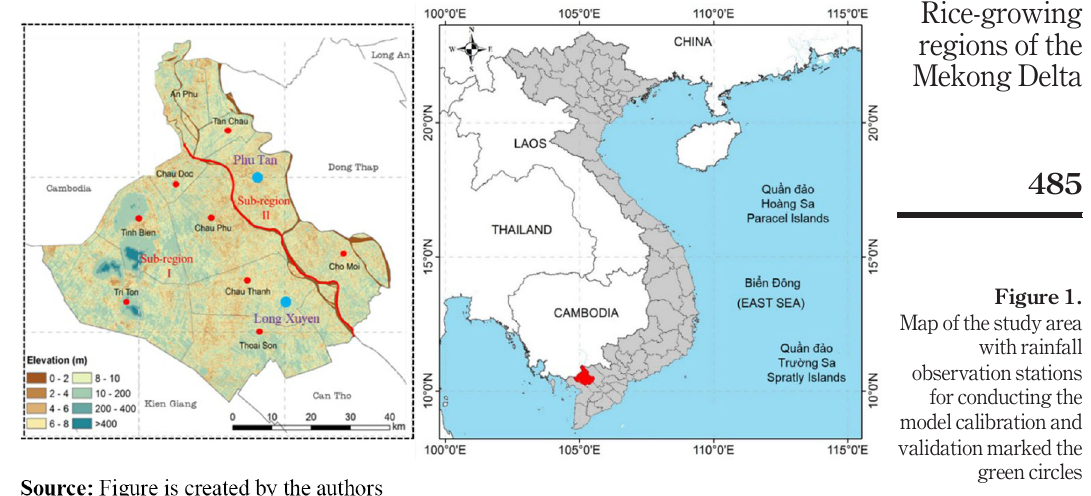
Figure 1. Map of the study area with rainfall observation stations for conducting the model calibration and validation marked the green circles